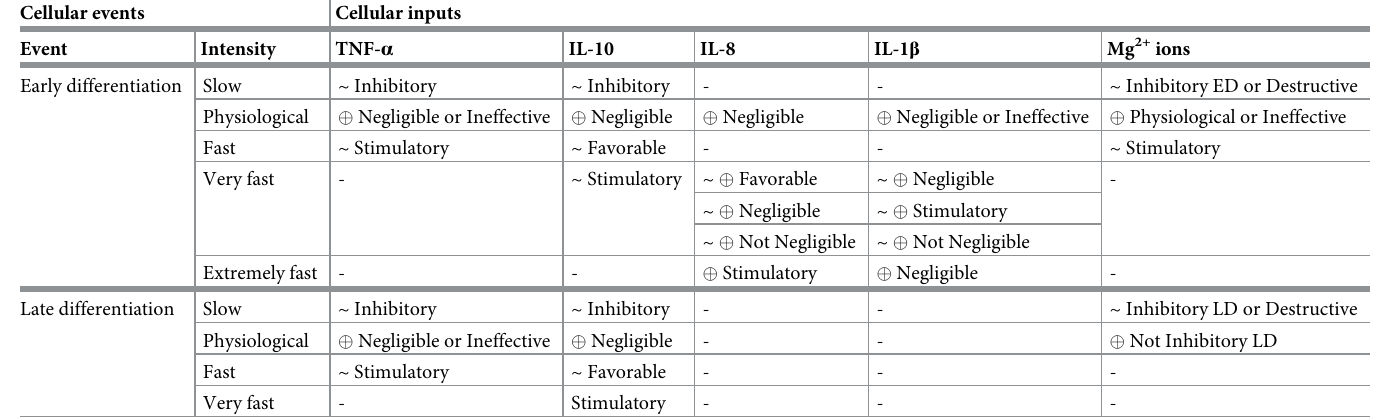
Table 1. Fuzzy logic rules define the osteogenic reaction in response to stimulatory inputs. For the qualitative definition of each linguistic term, refer to Fig 10A. The symbol � indicates that the given conditions must occur simultaneously to produce the given intensity. The symbol ~ indicates that any choice of one or more from the chosen inputs produces the same intensity. The term ‘Not’, preceded by a linguistic level, indicates that the rule applied for all except the given level. The terms ‘ED’ and ‘LD’ stand for early differentiation and late differentiation, respectively. The rules are given in IF/THEN format in S2 Table in. Cellular